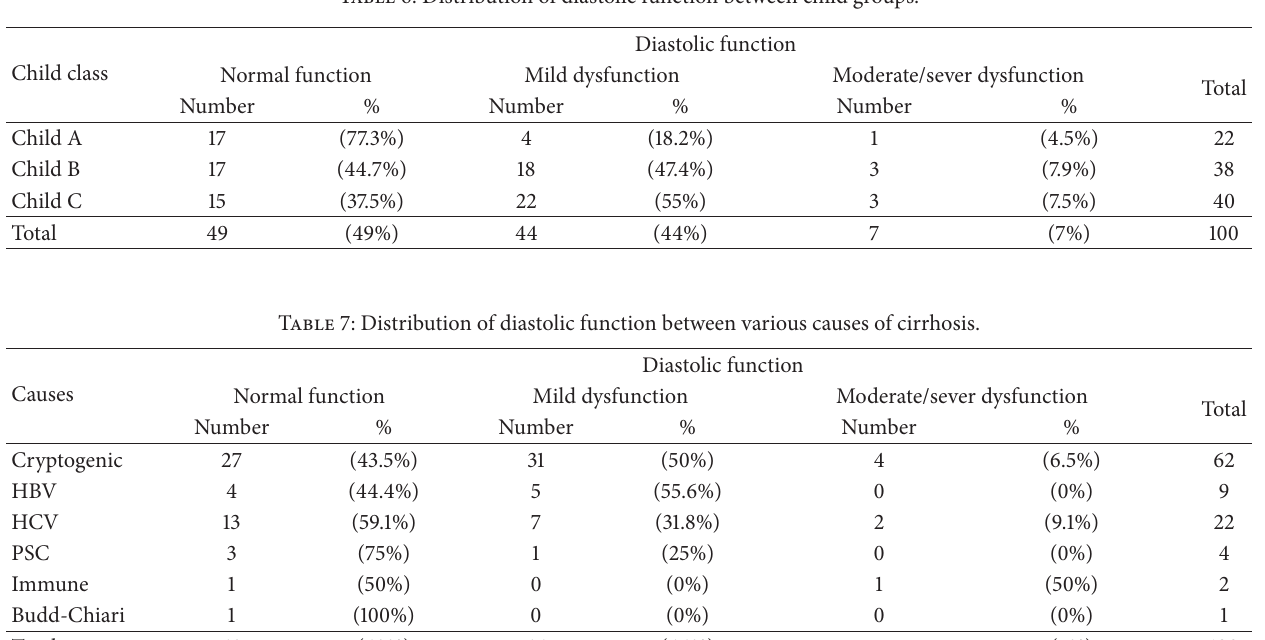
Table 6: Distribution of diastolic function between child groups.